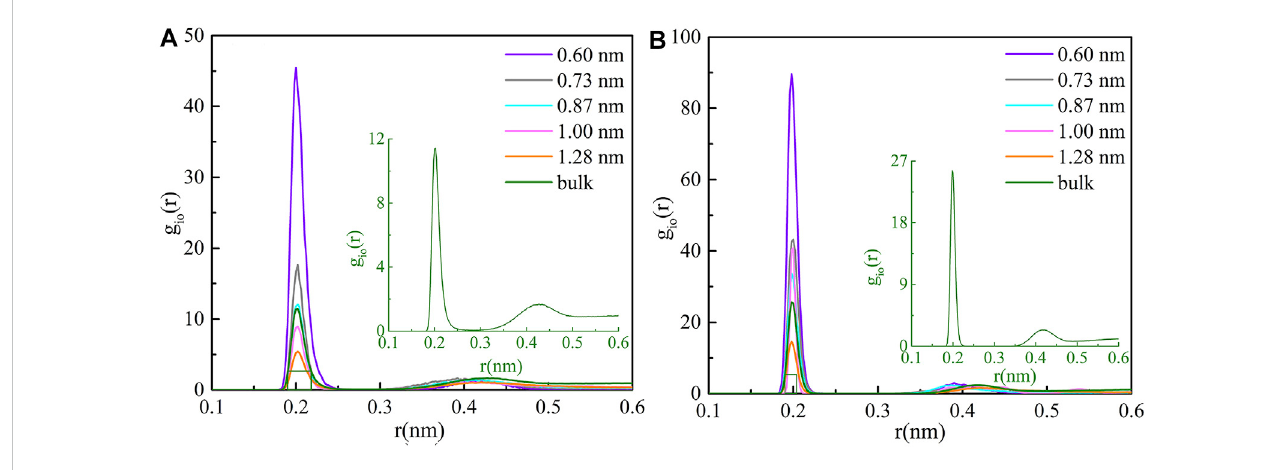
FIGURE 1 Ion RDFs for (A) Li + and (B) Mg 2+ inside various CNTs and the bulk solution.